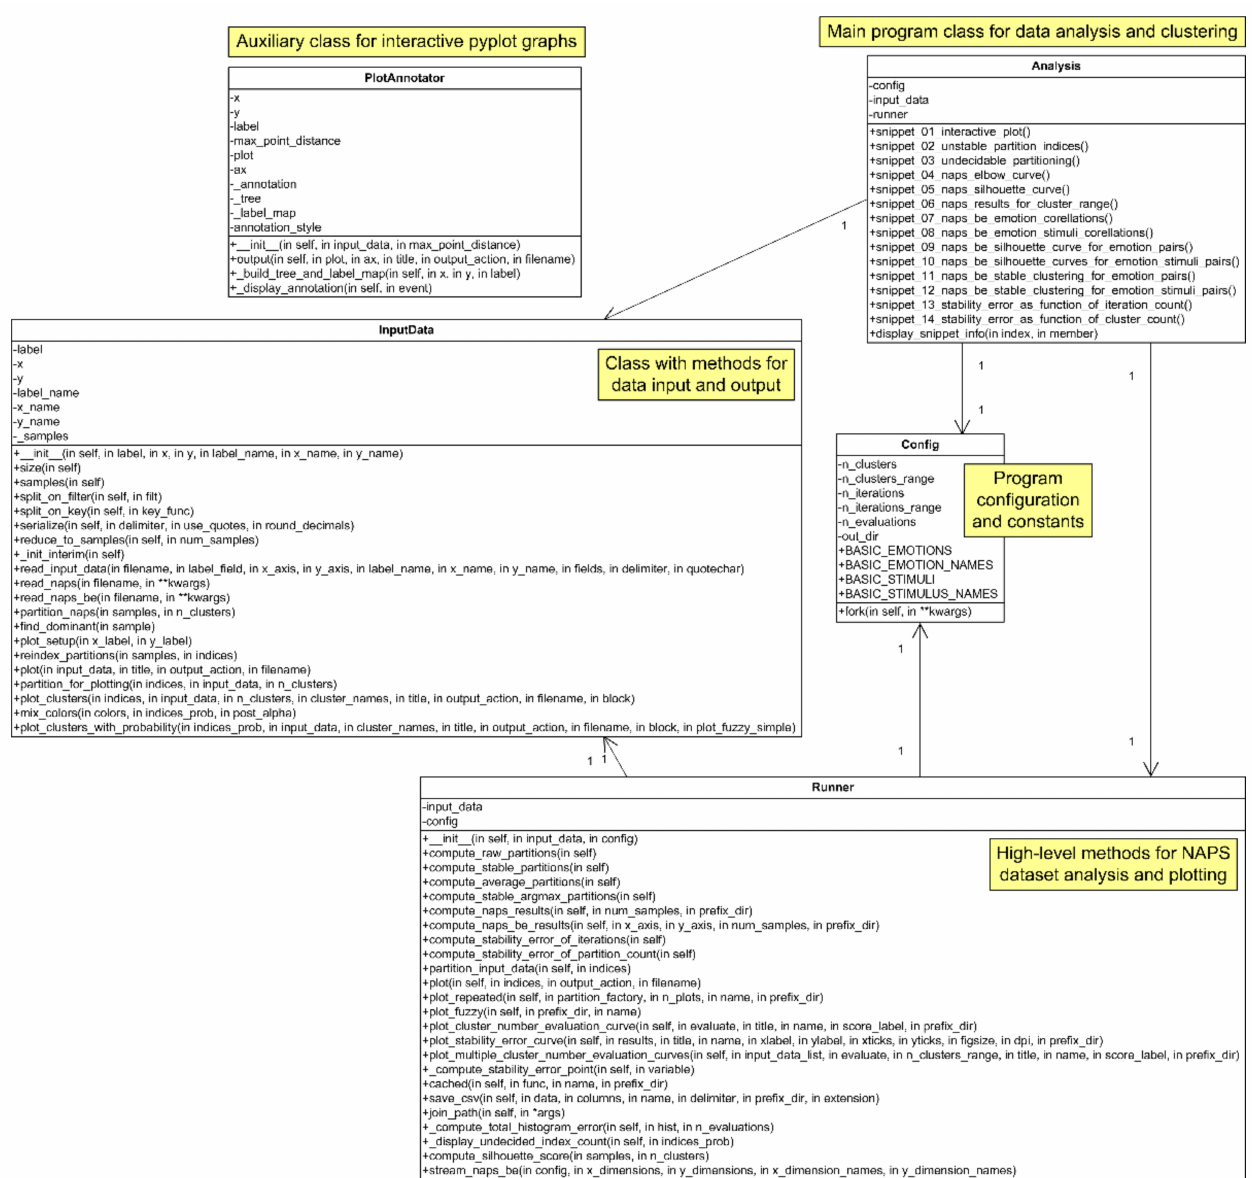
Figure A1. UML class diagram showing the software tool’s five functional class modules (Analysis, Runner, InputData, Config, PlotAnnotator), their attributes, operations and mutual